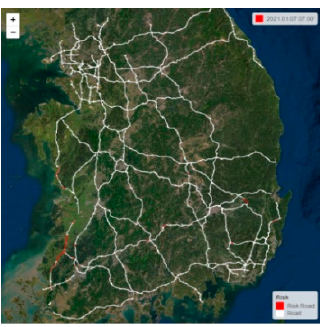
Figure 4. Risk of road accidents on highways caused by weather in Korea.